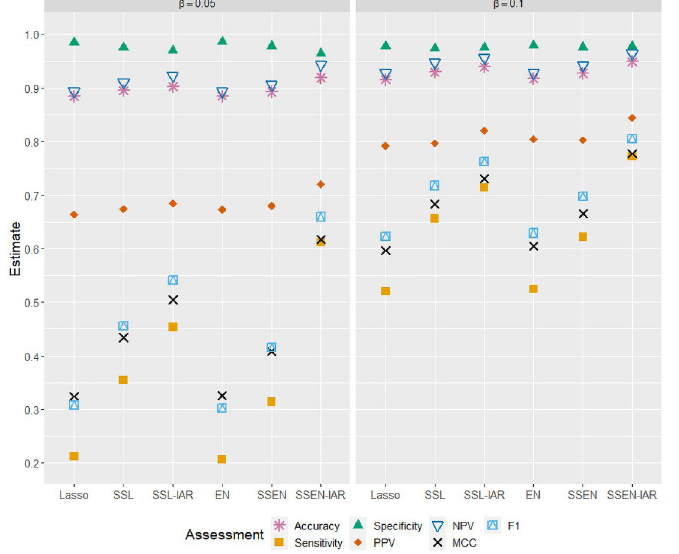
Fig 4. Simulation study classification performance when non-zero parameters are equal to 0.05 (LEFT) or 0.10 (RIGHT).